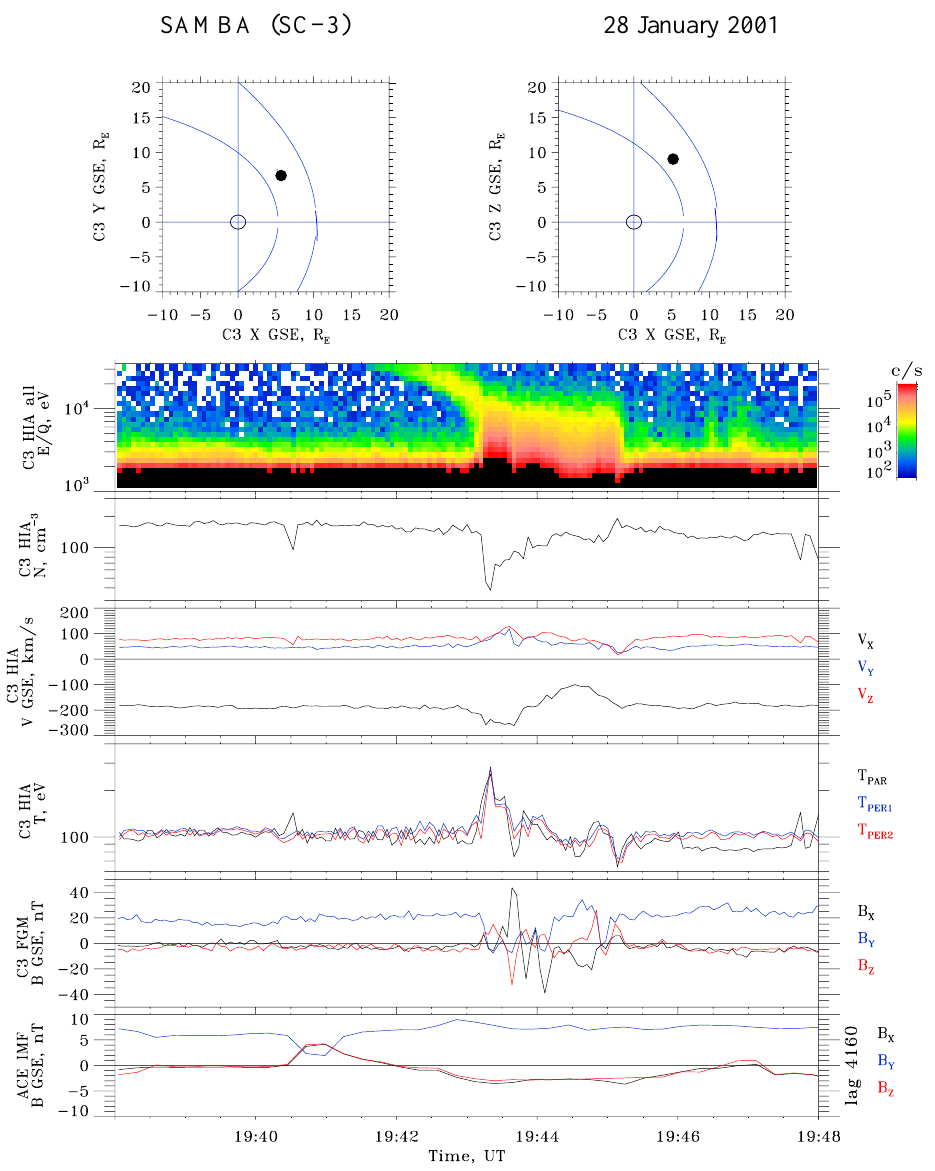
Fig. 3. Dispersed structure and associated HFA observed on day 28 January 2001. The CLUSTER position, the magnetopause and the shock are shown in the two upper plots. Data are presented below, from top to bottom: (1) Energy/time spectrogram from 2 to 30keV measured by CIS, (2) density, (3) plasma velocity, (4) parallel and perpendicular temperatures, (5) magnetic field measured by FGM and (6) magnetic field measured by ACE far upstream in the solar wind. It is shown with a delay of